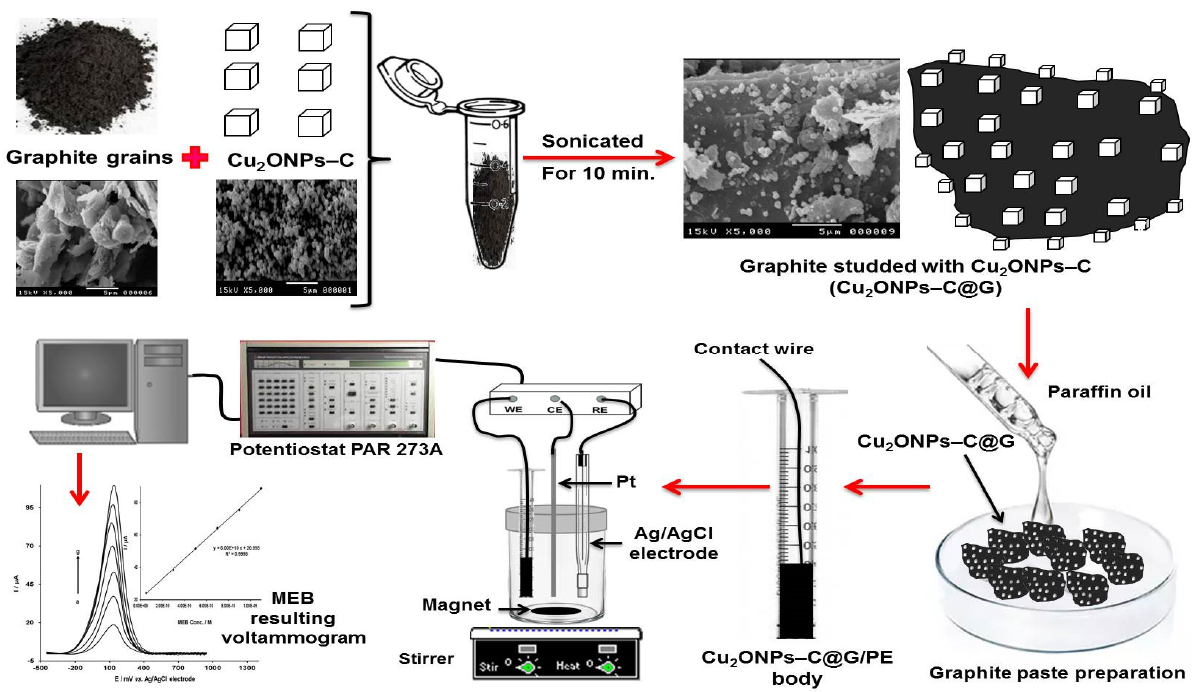
Figure 1. Description of Cu 2 ONPs–C@G and Cu 2 ONPs–C@G/PE preparation and the applied procedure for MEB volta- metric determination.